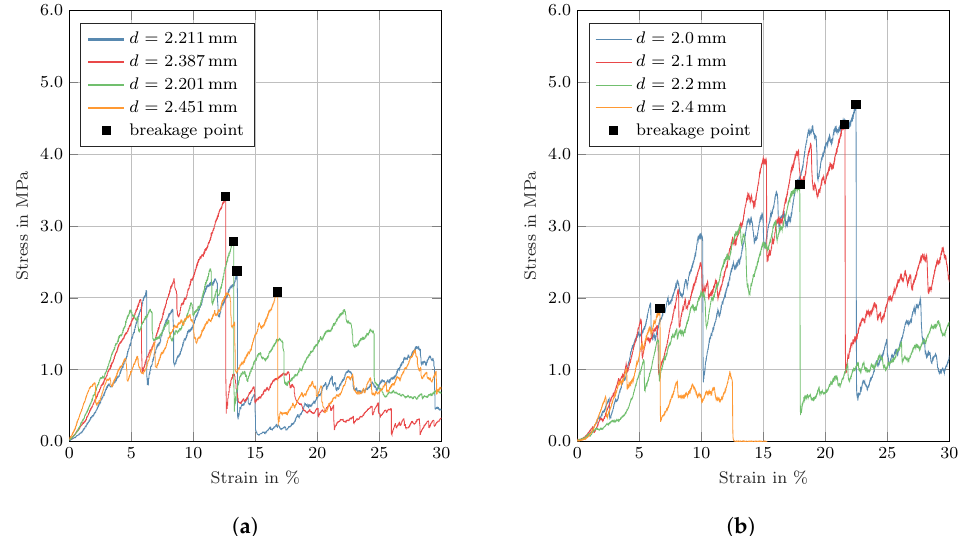
Figure 6. Stress–strain curves from single particls compression tests of four different Candelilla wax-coated and silicone-coated Poraver ® particles of diameter fraction 2.0–2.5 mm. ( a ) Poraver ® — Candelilla wax. ( b ) Poraver ®